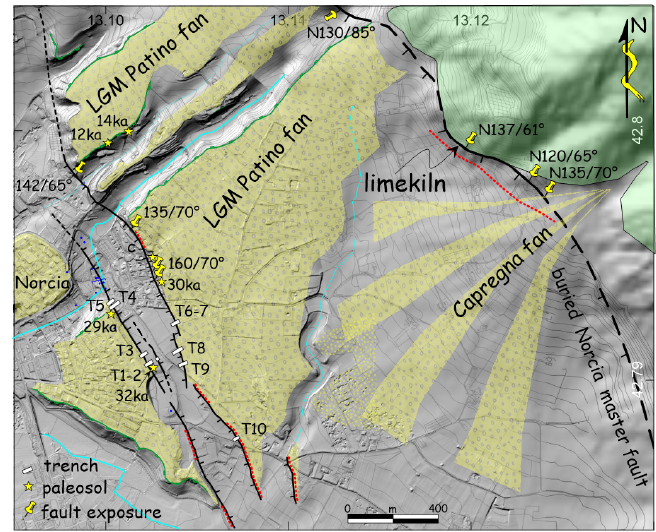
Figure 3. Shaded relief map of the Norcia area evidencing the faulted relic top-surface of the Late Pleistocene-post Last Glacial Maximum (>14–12 ka) alluvial fan of Patino (stars, 14 C dated paleosols). Note the NW-SE graben-like structure that downthrows the western nail of this fan (red dotted line indicate the 2016 re-activation), and the Norcia master fault traversing its apex. T1–10 are the paleoseismological trenches in [23]. Green, Meso-Cainozoic, marine carbonate basement. Gray, other Quaternary slope and alluvial deposits (Middle Pleistocene-Holocene). Table 1. Laboratory ages of samples considered in the study. AMS, accelerator mass spectrometry (Beta Analytic Inc., Miami, FL, USA). 2 σ calibration with software Calib 6.0.1